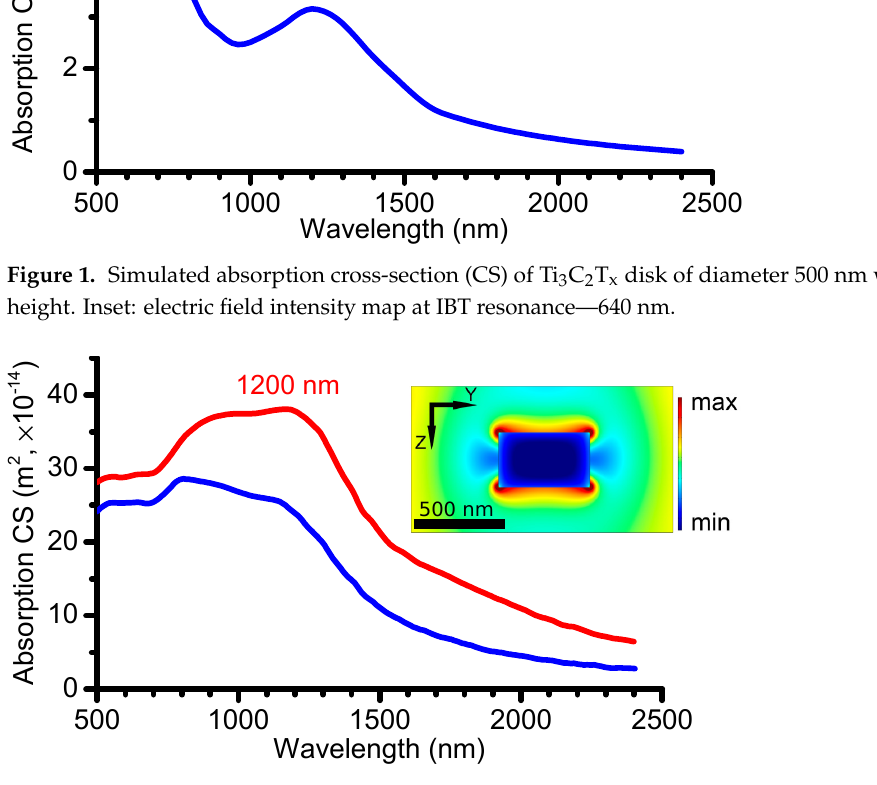
Figure 2. Simulated absorption CS of Ti 3 C 2 T x cylinder of diameter 500 nm with heights 200 nm (blue) and 300 nm (red). Inset: electric field intensity map of cylinder of diameter 500 nm with height 300 nm at the wavelength of TSP resonance—1200